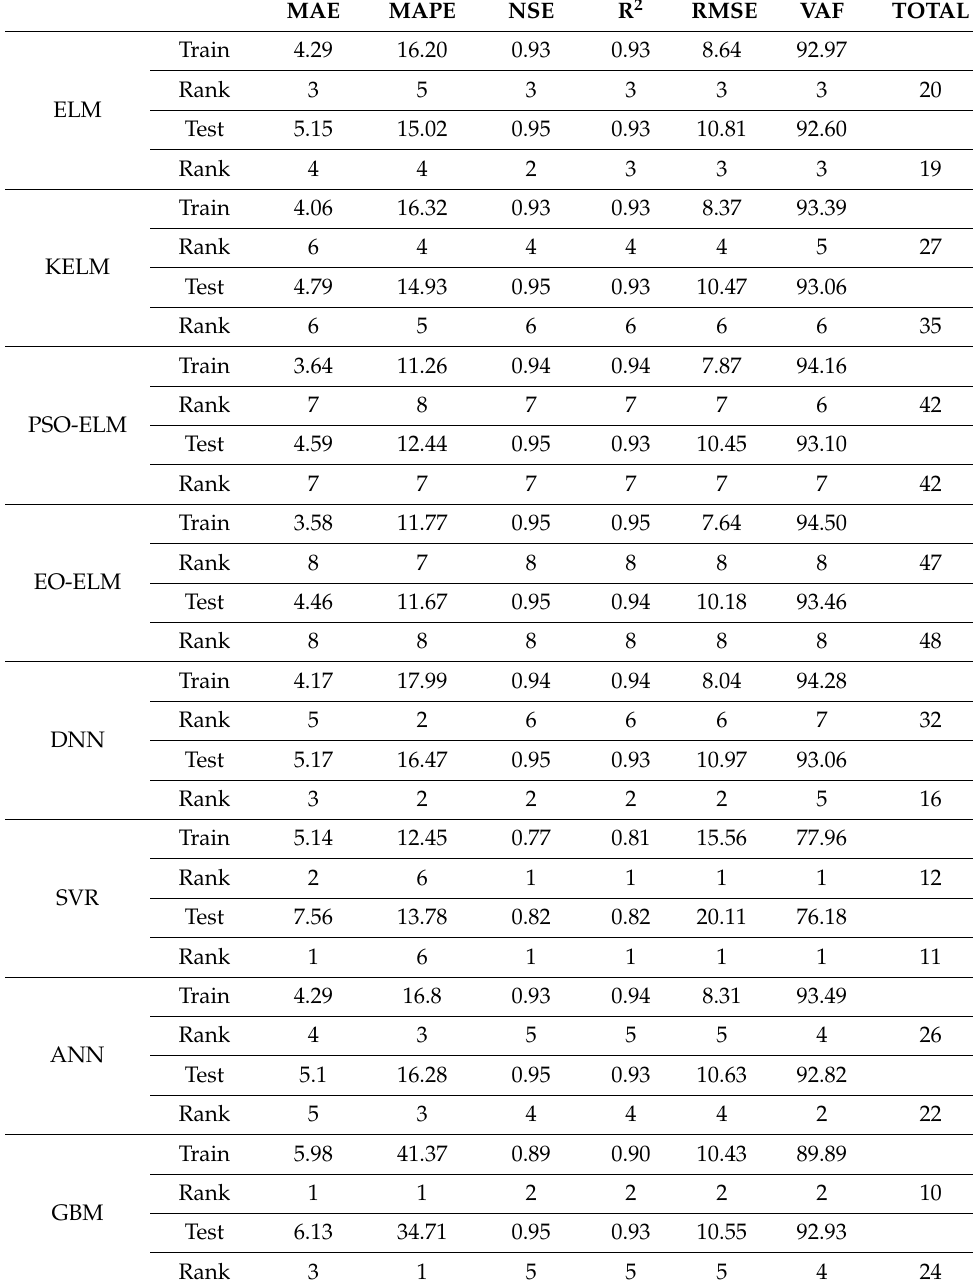
Table 4. Lag-based models’ performance evaluation of the catchment Teifi at